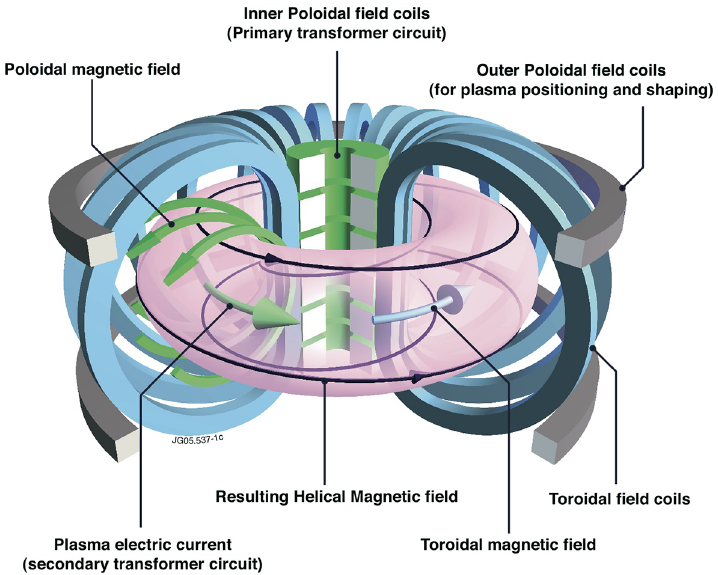
Fig. 2. – Magnetic confinement geometry illustrated for the tokamak configuration, see text (courtesy